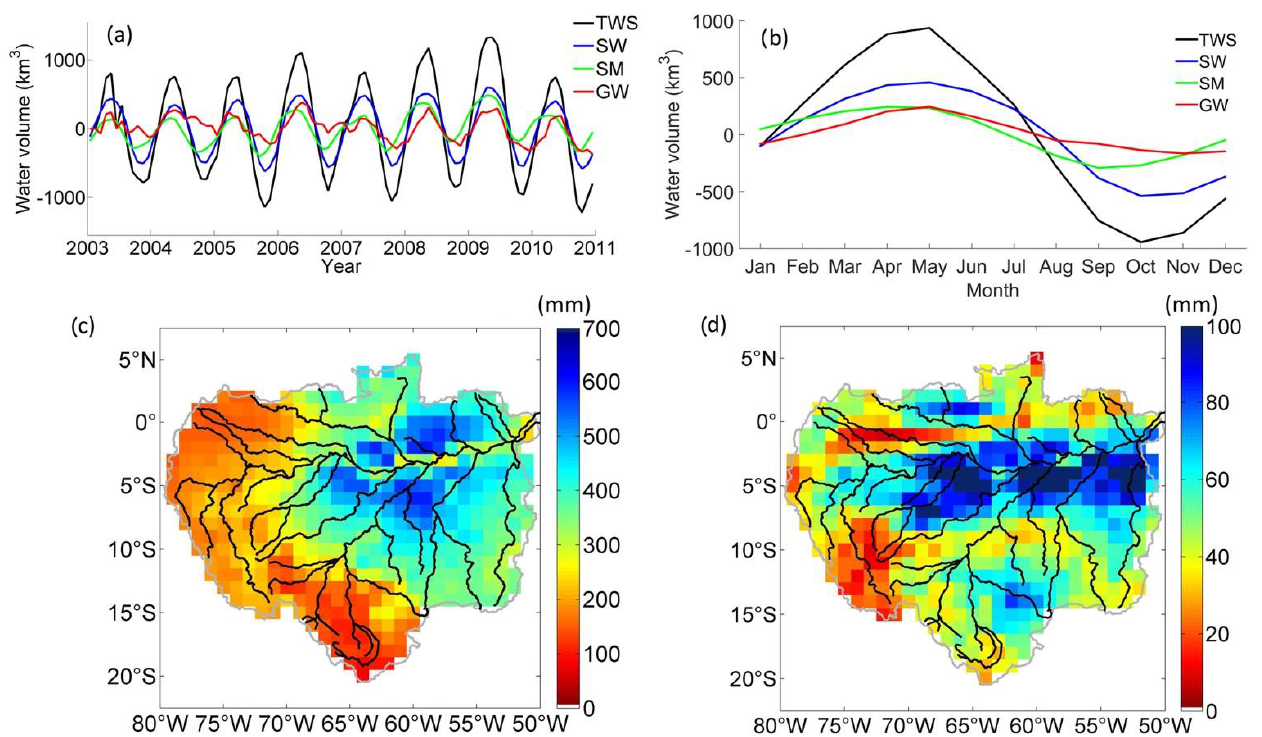
Figure 7. ( a ) Time variations (2003–2010) over the Amazon basin of total water storage (black) from GRACE, surface water storage (blue) from multi-satellite observations, soil moisture storage (green) from WGHM model, and groundwater storage (red) when the contribution of SWS and SMS are removed from TWS. ( b ) Same as ( a ) for the mean annual cycle. ( c ) Mean annual changes (2003–2010) in groundwater storage over the Amazon basin. ( d ) Variability in groundwater storage over the Amazon basin (standard deviations 2003–2010). Reprinted with permission from [70] 2019 Elsevier.